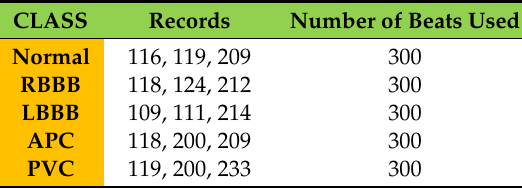
Table 1. MIT-BIH arrhythmia records used in this study. RBBB: right bundle branch block; LBBB: left bundle branch block; APC: atrial premature contraction; PVC: premature ventricular contraction.